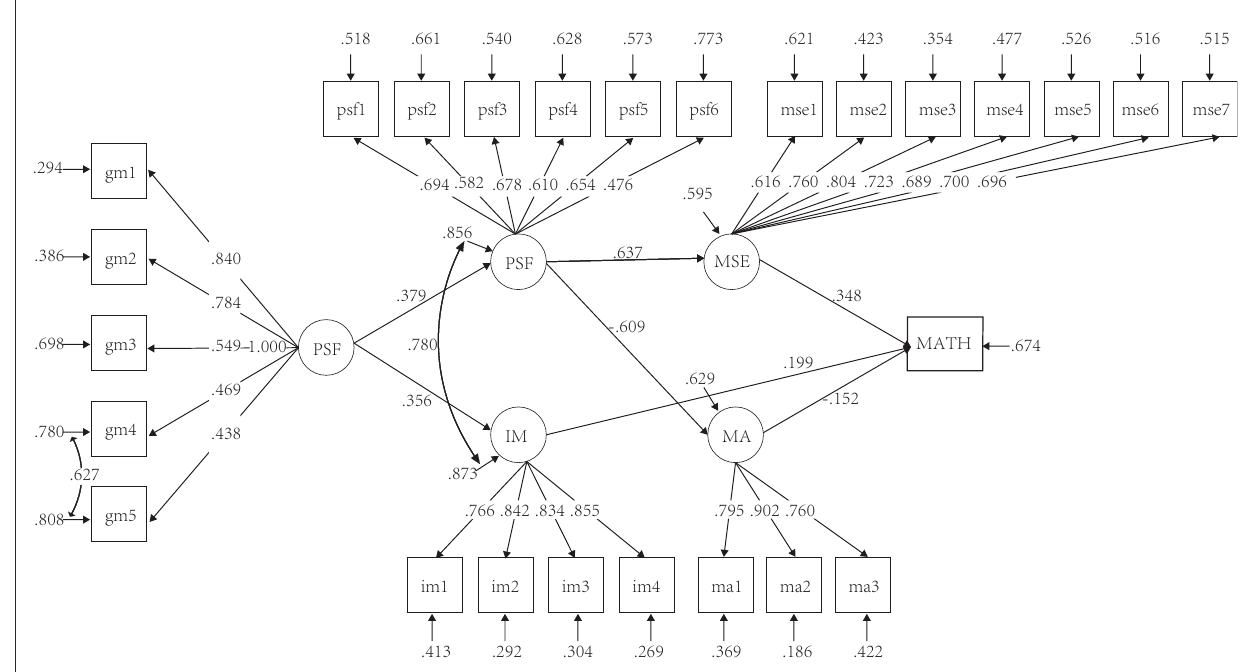
FIGURE2 The structural equations model of the relationships growth mindset. GM, growth mindset; MSE, mathematics self-efficacy; IM, intrinsic motivation to learn mathematics; MA, mathematics anxiety; PSF, perceived self-responsibility for failing in mathematics; MATH, mathematics achievement. All paths p < 0.05.